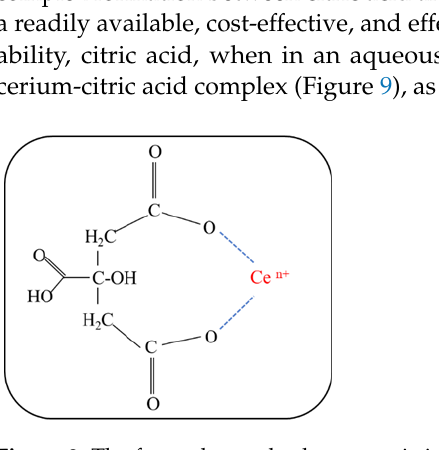
Figure 9. The formed complex between citric acid and cerium cation.